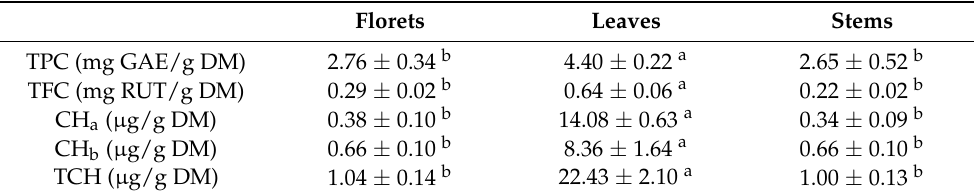
Table 3. Total phenolic, flavonoid and chlorophyll contents in the aerial parts of cauliflower expressed as mean ± SD ( n = 9).